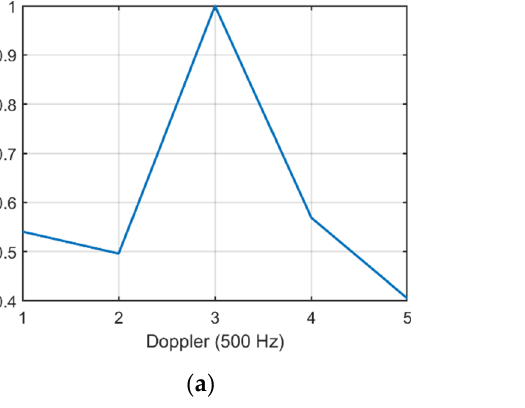
Figure 5. Averaged DDM: ( a ) Delay dimension ( b ) Doppler frequency dimension. Table 3. GNSS-R NN error with respect to the input variables (I).